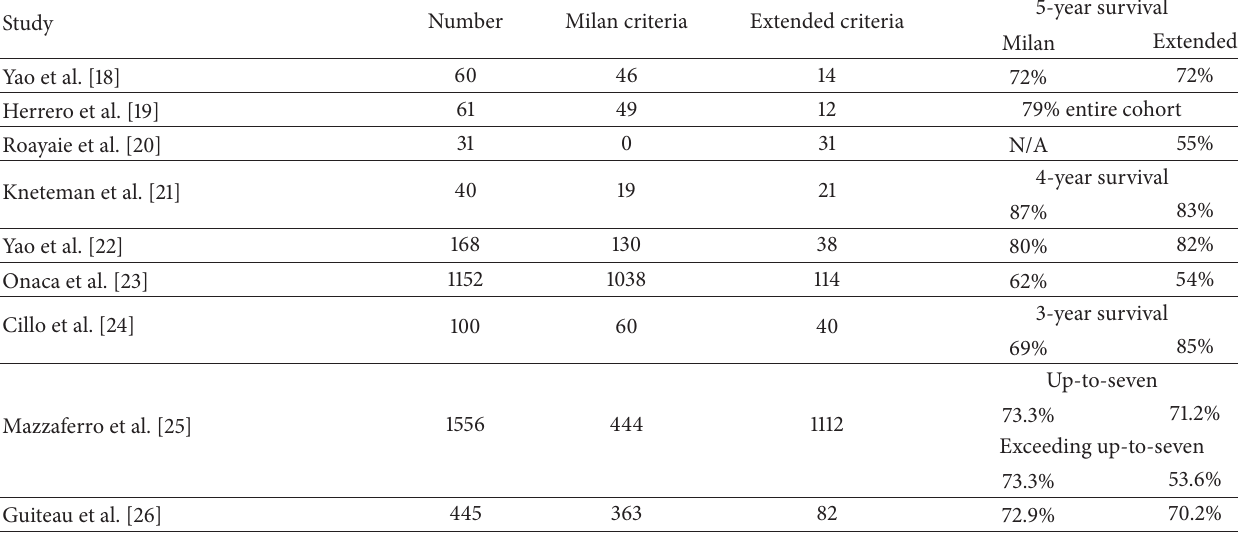
Table 1: Comparison of survival; Milan versus extended